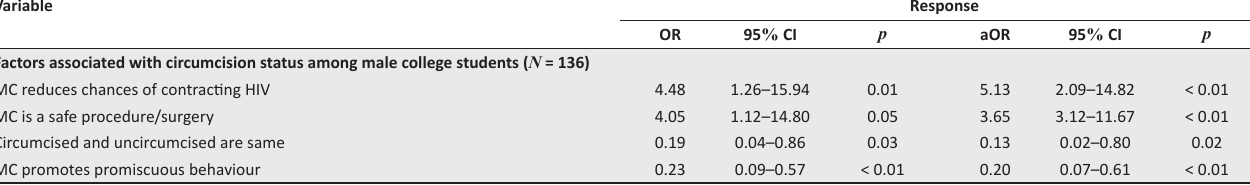
TABLE 2b: Exposure variables for male circumcision status among college youth, Ndola – 2016 ( N = 136). Variable